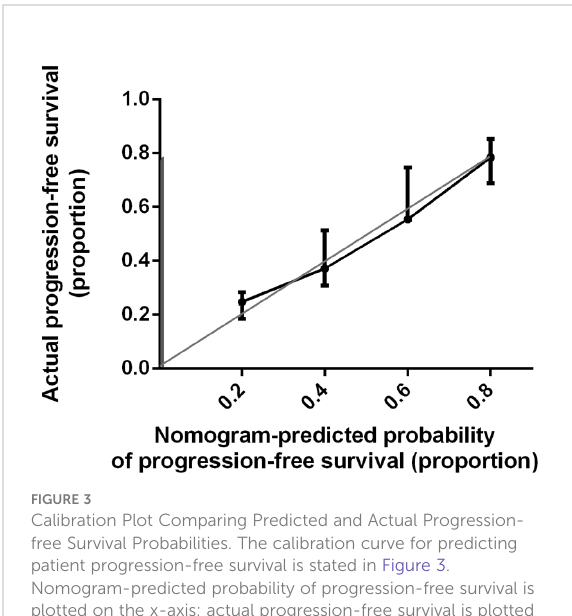
FIGURE 4 Calibration Plot Comparing Predicted and Actual Overall Survival Probabilities. The calibration curve for predicting patient overall survival is stated in Figure 4. Nomogram-predicted probability of overall survival is plotted on the x-axis; actual overall survival is plotted on the y-axis. Thin gray line represents the reference